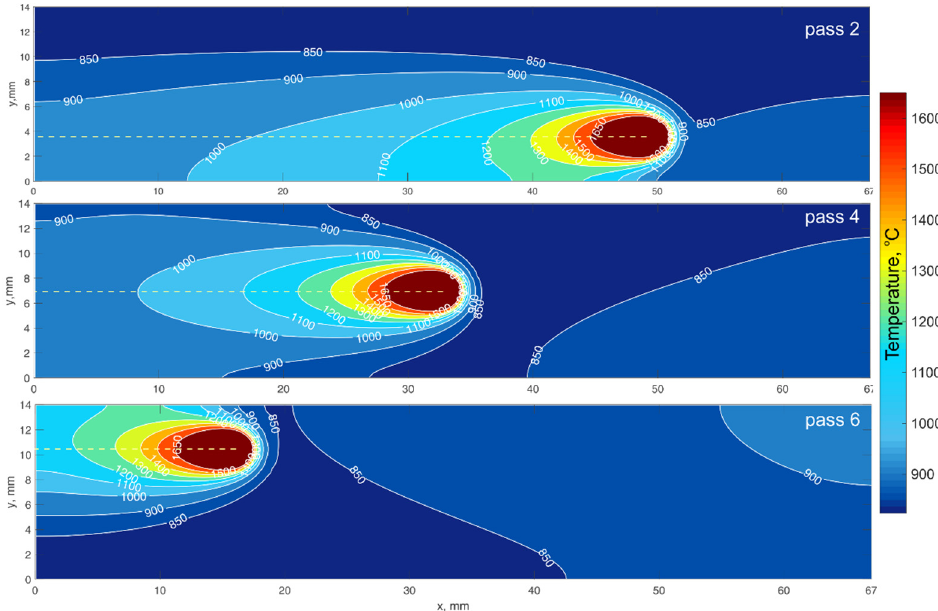
Figure 11. The calculated distribution of the wall surface temperature during the depositing of 2nd, 4th, and 6th passes of the 16th layer.